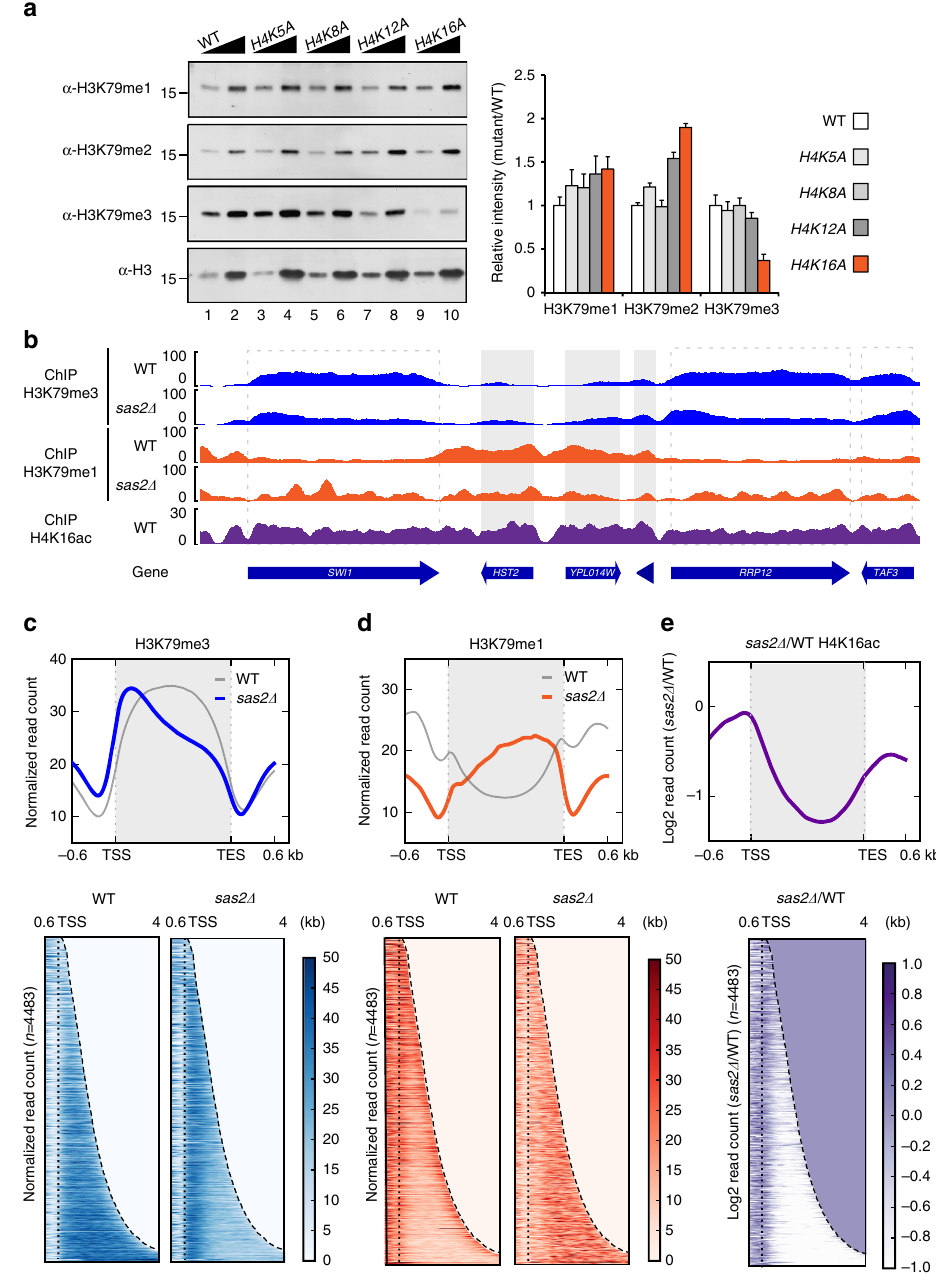
Fig. 1 H4K16 acetylation regulates the Dot1p-mediated distribution of H3K79 methylation on euchromatin. a Western blot analysis for the levels of H3K79 mono-/di-/tri-methylation in histone lysine-to-alanine mutant strains. We used wzy42 strains of which the sequences of HHT1-HHF1 and HHT2-HHF2 genes are deleted, and maintained by the inserted plasmid pwz414-F13-HHT2-HHF2 to express histone H3 and H4. We modi fi ed the plasmid to express mutant histones H3 and H4. The right panel shows a quanti fi cation of the western blot data from three repeats. The error bars represent the s.d. for the biological replicates. b Distribution of H3K79me3 (blue) and H3K79me1 (orange) in wild-type and sas2 Δ mutant cells. The values of the y -axis indicate normalized ChIP-seq read counts. The ChIP-seq data were obtained from biological duplicates. The distribution of H4K16ac in wild-type cells was indicated in purple. The dotted-line boxes indicate transcribed regions ( SWI1 , RRP12 , and TAF3 ), while the gray boxes ( HST2 , CIP1 , and MRPS16 (indicated as a triangle with no gene name label)) mark regions with low H3K79me3 levels. c , d Heatmaps and average plots showing the distributions of H3K79me3 ( c , blue) and H3K79me1 ( d , orange) in wild-type and sas2 Δ mutant cells. e The H4K16ac level calculated as the log 2 fold change in sas2 Δ cells over wild-type cells (purple). The average plot and heatmap indicate differential distribution of H4K16ac on transcribed regions. Pro fi les are sorted by ascending length of their transcribed regions. c – e The genes were sorted in descending order of their H3K79me3 levels on transcribed regions in sas2 Δ cells ( n = 4483). The read count data were obtained from biological duplicates. In the average plots, the values of the y -axis indicate normalized ChIP-seq read counts, and the x -axis indicate distance from transcription start sites (TSS) and transcription end sites (TES). For the heatmaps, the y -axis indicates each genes and the x- axis indicates distance from TSS. The genes in heatmap was arranged in order of length. The intensity of color indicates the value of normalized read counts from 0 to 50. The dotted lines indicate the TSS and TES. All values were normalized to the read count, and the value of the region exceeding the TES was treated as